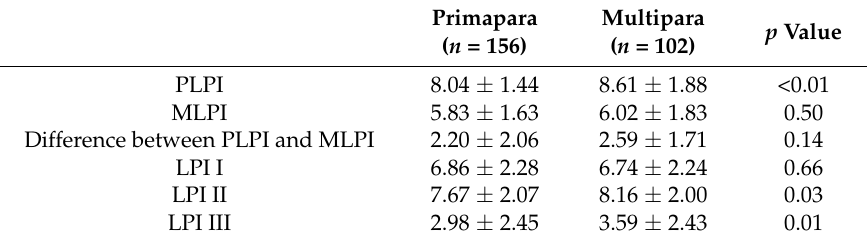
Table 2. Comparison of pain assessment between primaparas and multiparas.